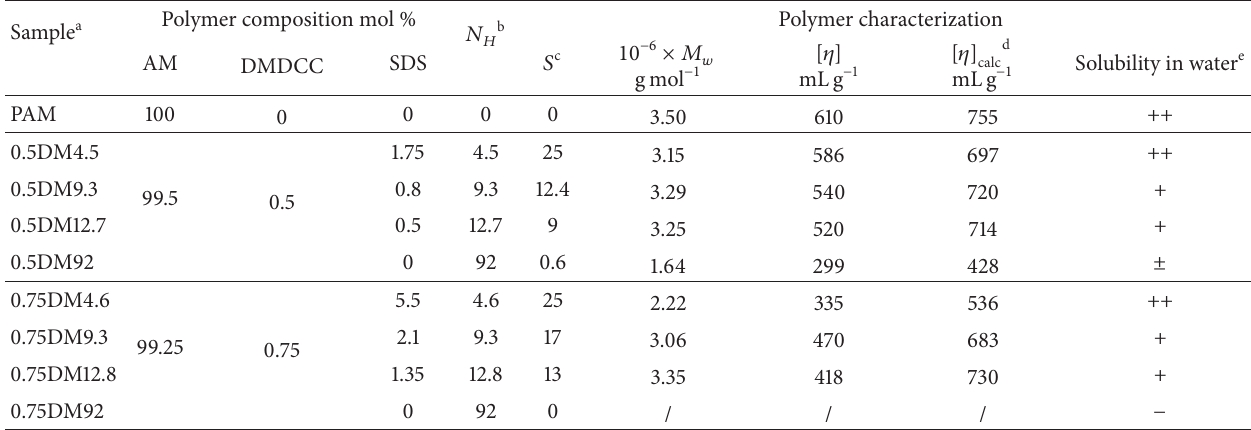
Table 1: Structural parameters of the copolymers.